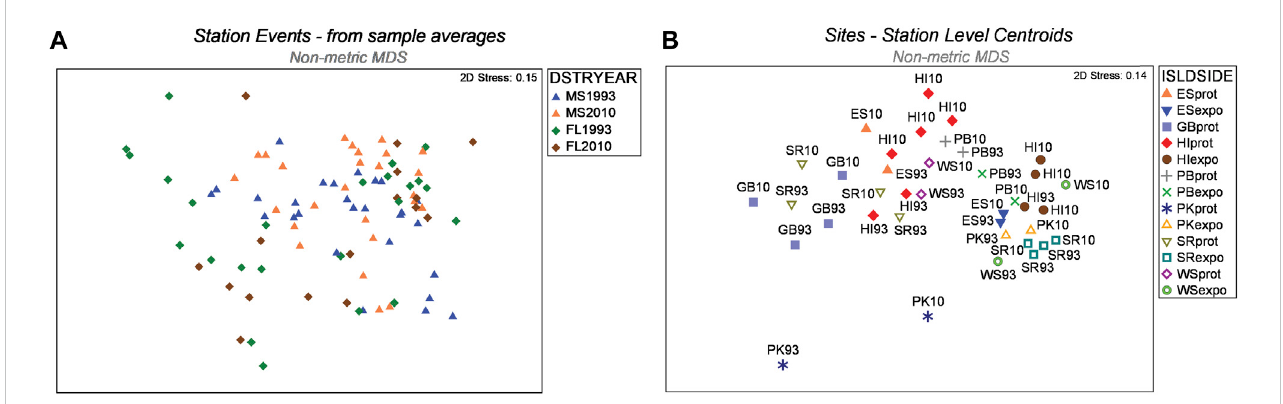
FIGURE 4 (A) Ordination of nMDS coordinates for station events. Coordinates overlap less between districts than between years (legend codes: DSTRYEAR - District/Year; MS – western district; FL eastern district; (B) . Site centroids of station coordinates in 2-D nMDS space illustrating macrofaunal af fi nity based on islandidentity,region,andshoreside(i.e.,exposedvsprotectedlegendcodes:ISLDSIDE,Island/Side;ES,EastShipIsland;GB,GulfBreeze;HI,HornIsland;PB, Petit Bois Island; PK, Perdido Key; SR, Santa Rosa Island; WS, West Ship Island; prot, protected; expo, exposed).